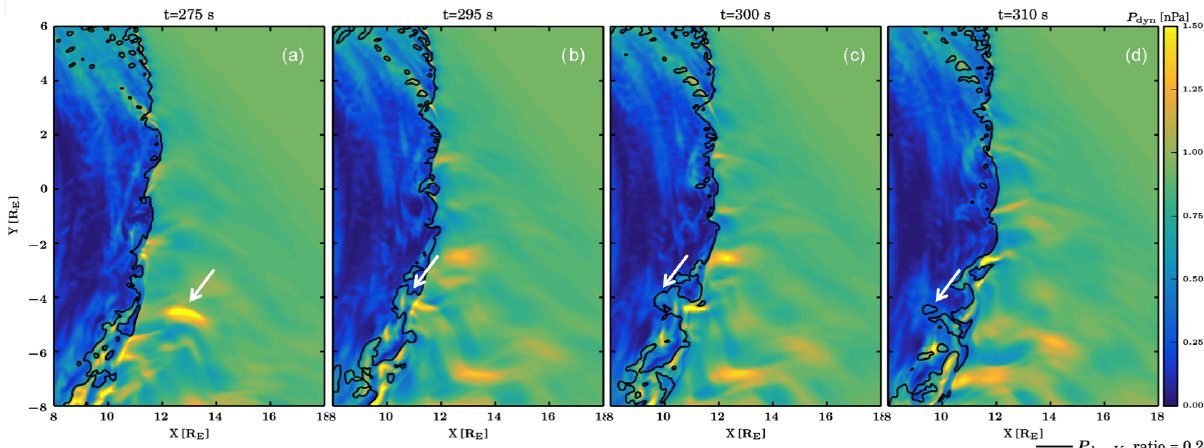
Figure 8. Time evolution of the jet. The color coding in the background shows the total dynamic pressure, while the black contour shows the Plaschke criterion C P computed using the X component of the velocity v X in dynamic pressure. Panels (a) to (d) show times 275, 295, 300, and 310s, respectively, from the start of the simulation. The time of the jet at its prime is shown in Fig. 5. The white arrows show the jet generation and are referred to in the text. The panels are snapshots of movie